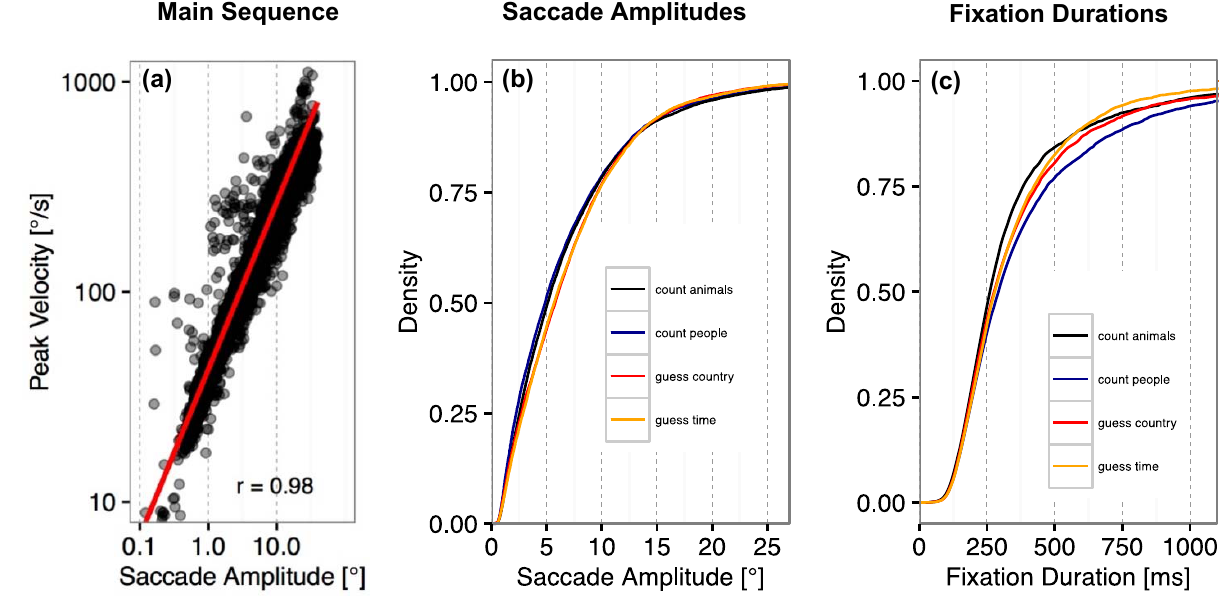
Figure 1. Results of the scene viewing experiment: (a) Main Sequence; (b) Saccade Amplitudes; (c) Fixation